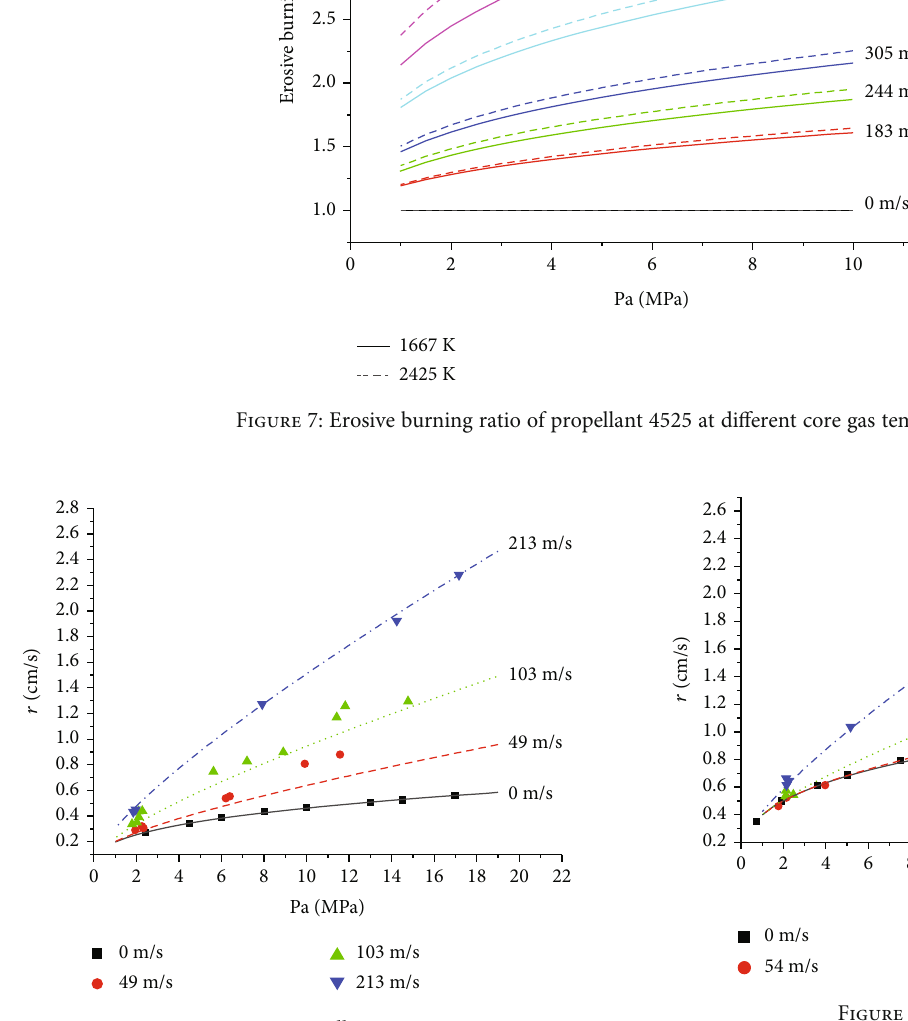
Figure 8: Propellant A.